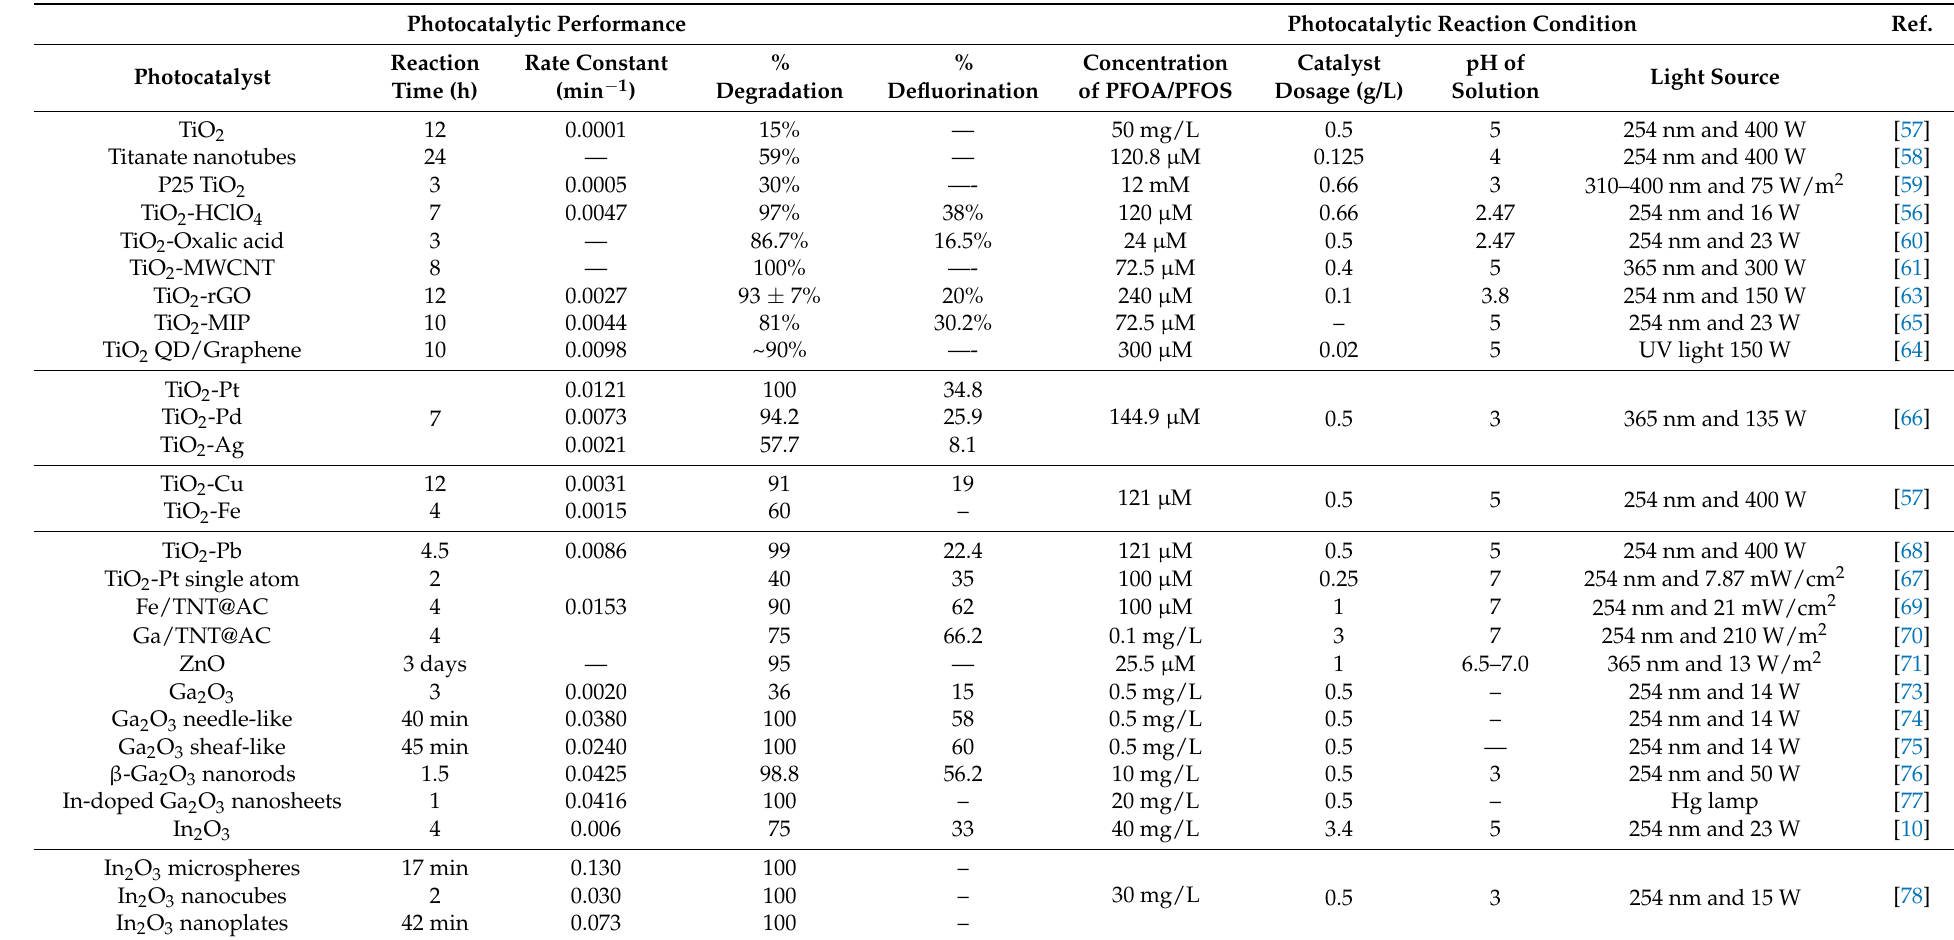
Table 1. Heterogeneous photocatalysis applied to PFAS